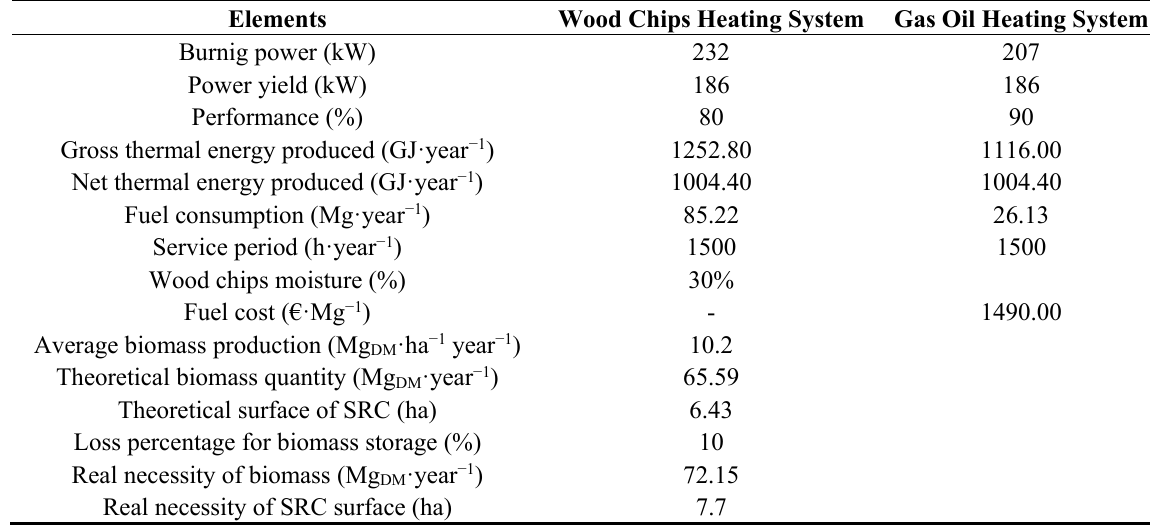
Table 5. Principal elements used to calculate the consumption of the fuel and the costs of the different heating systems.